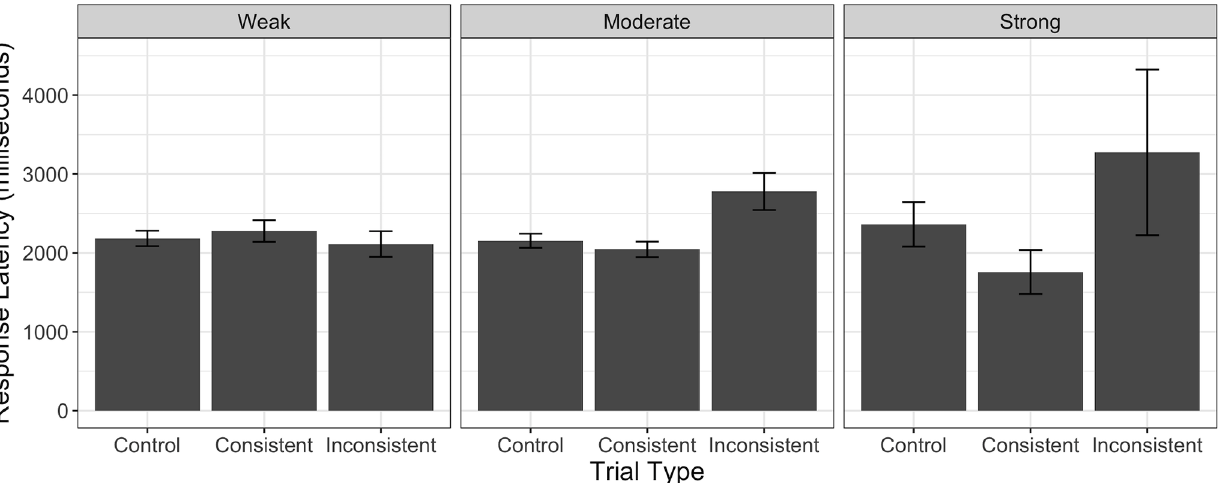
Figure 4. Effect of trial type on response latency as a function of ideological extremity (weak, moderate, strong) in Experiment